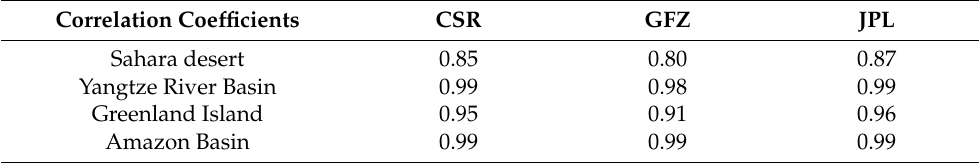
Table 2. Correlation coefficients between UCAS_IGG and CSR, GFZ,